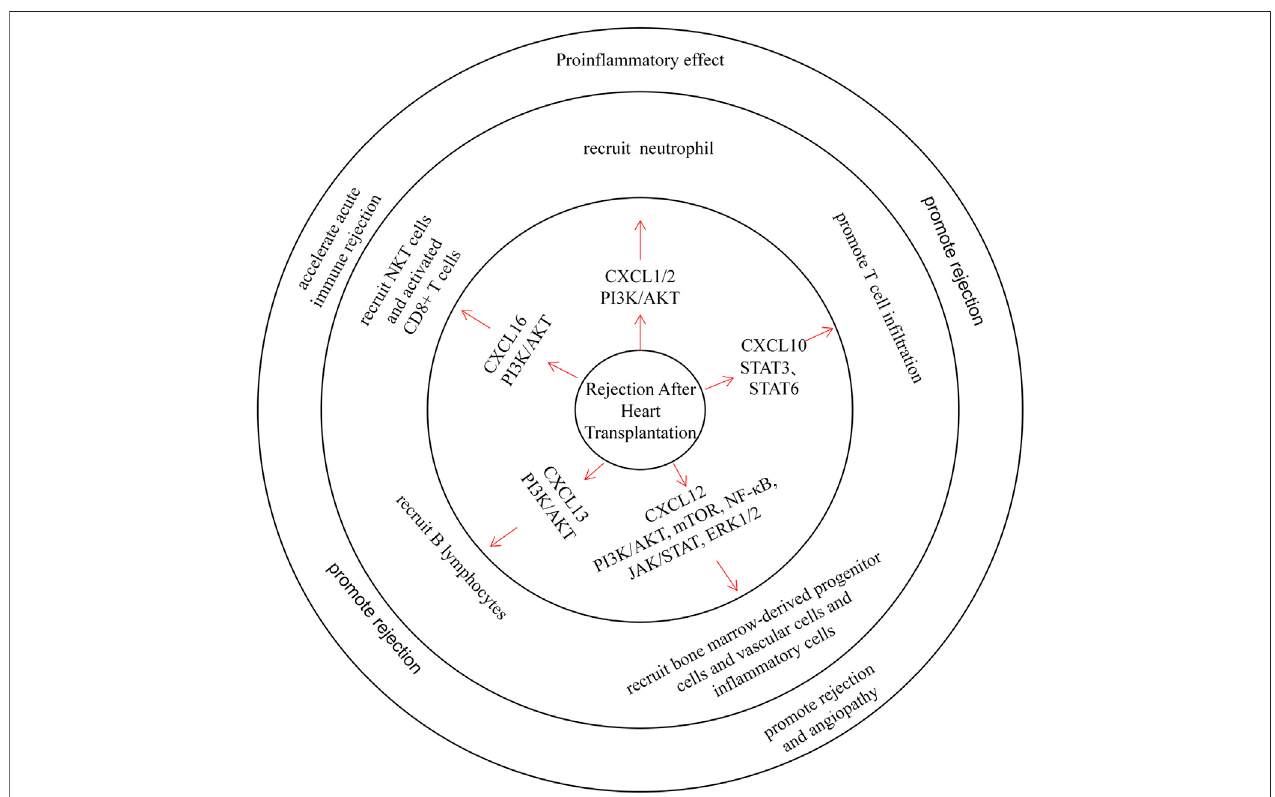
FIGURE5| CXCchemokinesinRejectionAfterHeartTransplantation.CXCL1/2recruitsneutrophilsandplaysapro-in fl ammatoryrole.CXCL10canpromoteTcell in fi ltration and promote rejection. CXCL12 recruits bone marrow-derived progenitor cells, vascular cells, and in fl ammatory cells through multiple pathways, promoting rejection and angiopathy. CXCL13 recruits B lymphocytes and promotes rejection. CXCL16 recruits NKT cells and activated CD8+ T cells, which can accelerate acute immune